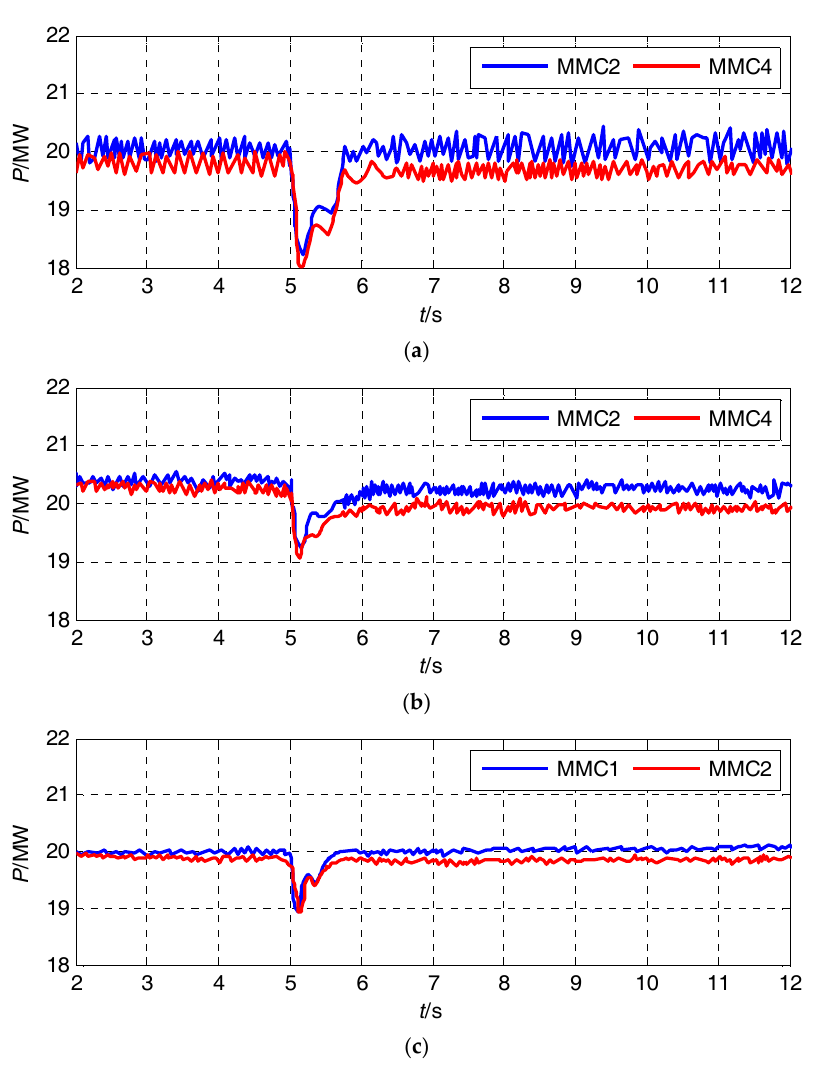
Figure 11. Simulation of the operation during an exit of the input converter station: ( a ) The DC voltage controlled by DCLC; ( b ) the DC voltage controlled by FCS-MPC; ( c ) the DC voltage controlled by HM 2 PC.